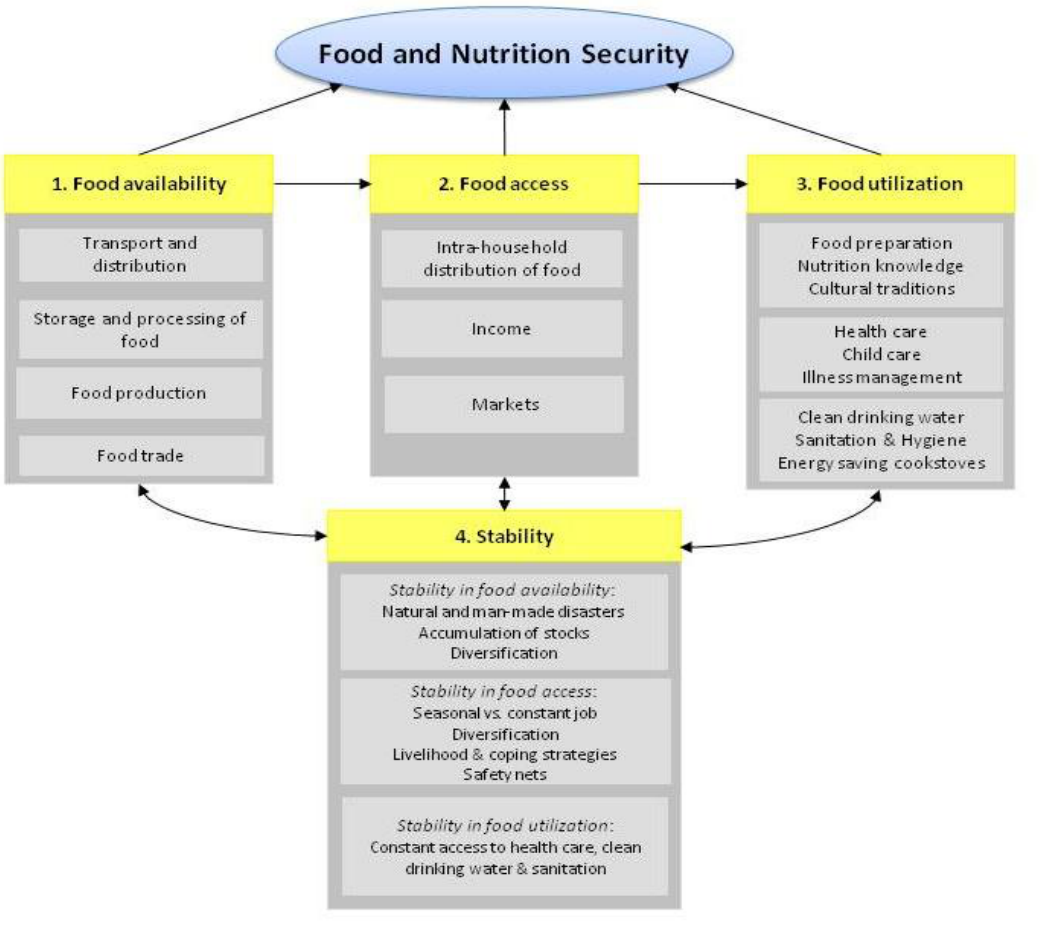
Figure 1. The four dimensions of food